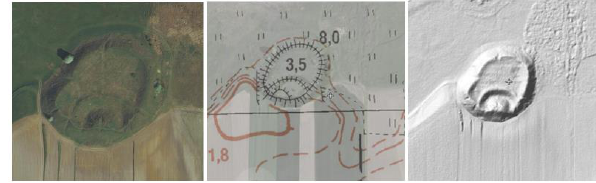
Figure 2. Example of Slavic settlement represented by different data types, from the left: orthoimage, topographic map and DTM